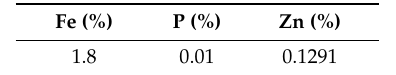
Table 2. Composition of Cu matrix in alloying element-depleted regions. Table 1. Alloy’s composition.